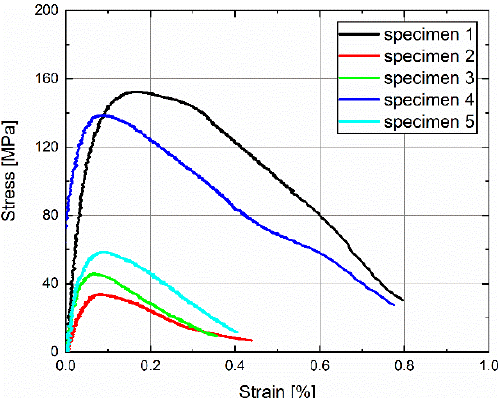
Figure 7. Stress-strain curves depicting the residual mechanical properties of laser-welded AISI 430Ti specimens following exposure to boiling 16% boiling sulfuric acid for a duration of 20 h. All specimens were extracted from a single weld seam following corrosion testing.